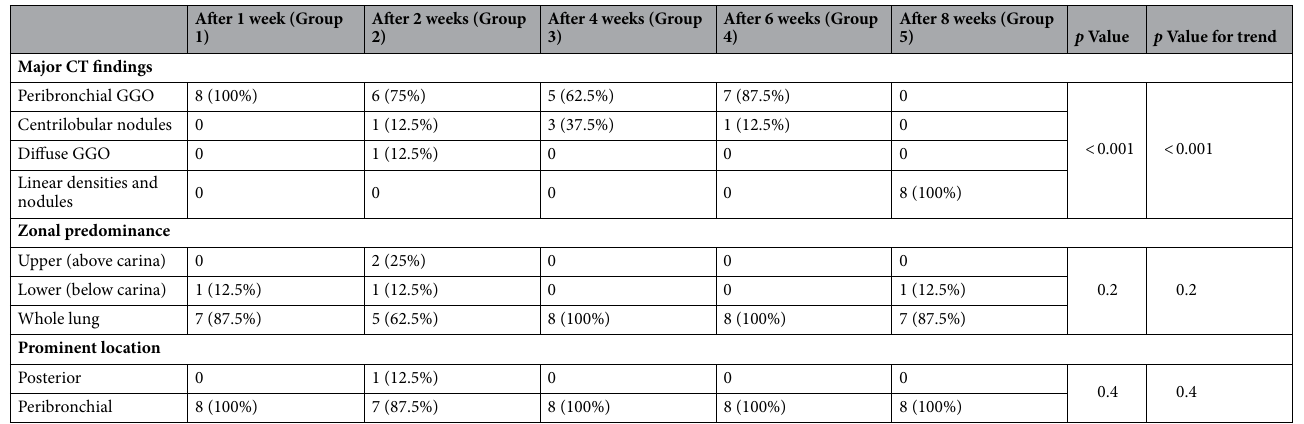
Table 2. Major CT findings, zonal predominance, and prominent location of CT findings according to the groups. GGO, ground glass